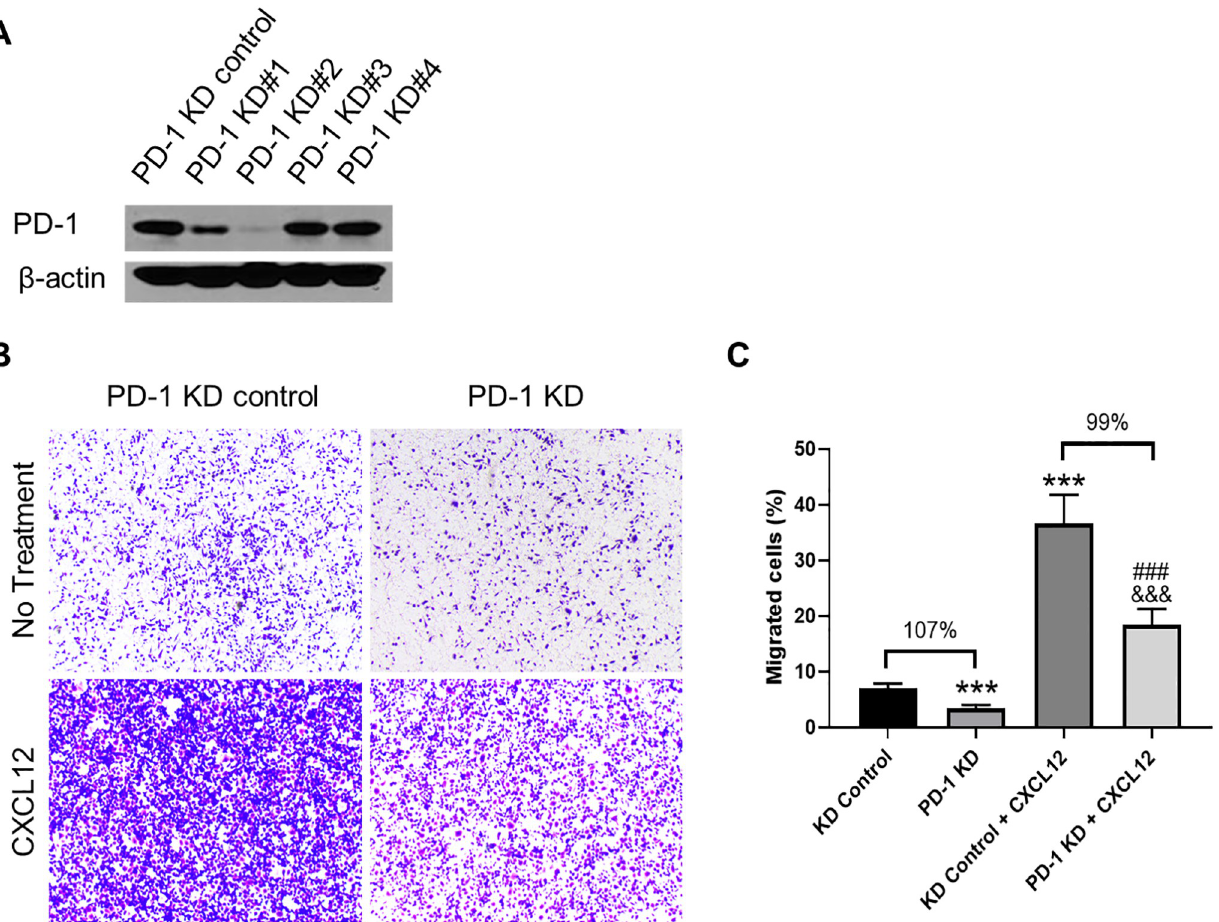
Fig 6. PD-1 knockdown in MIAPaCa-2 cells attenuates CXCR4 downstream pathways. ( A ) MIAPaCa-2 PD-1 KD was most successful in decreasing PD- 1 in construct #2. ( B ) PD-1 KD cells demonstrated decreased migration even when cells were exposed to CXCL12 (100 ng/mL). ( C ) Quantification of transwell migration assays demonstrated a 107% decrease in migration in PD-1 KD cells compared to KD control. When treated with CXCL12, PD-1 KD cells had a 99% less migration than KD controls. ( ��� p < 0.001 vs. KD control; ### p < 0.001 vs. PD-1 KD; &&& p < 0.001 vs. KD control +